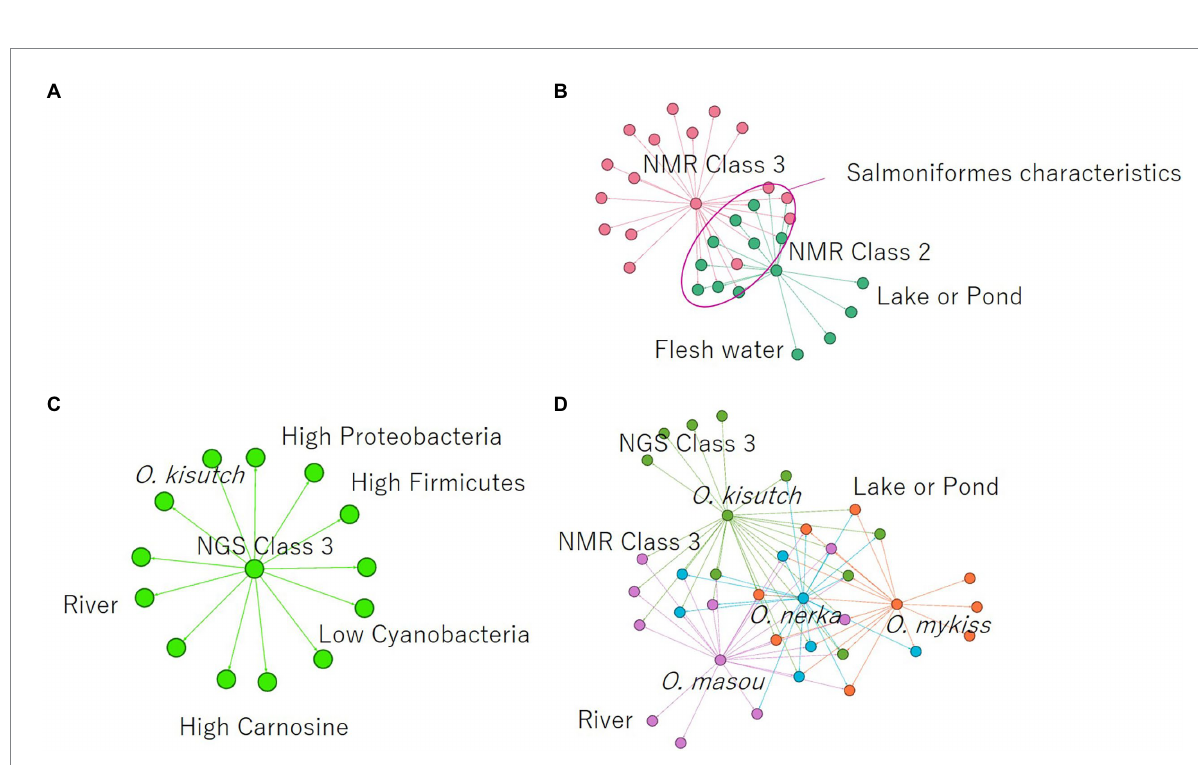
FIGURE 5 Extraction of association rules using the a priori algorithm. (A) Rules for all annotated NMR signals, NGS data, and nonnumerical information. (B) Association rules centered on NMR class classified using i-means. (C) Association rules centered on NGS class classified using i-means. (D) Association rules on salmoniformes genus. Color coding indicates modularity automatically calculated by an open software Gephi (https://